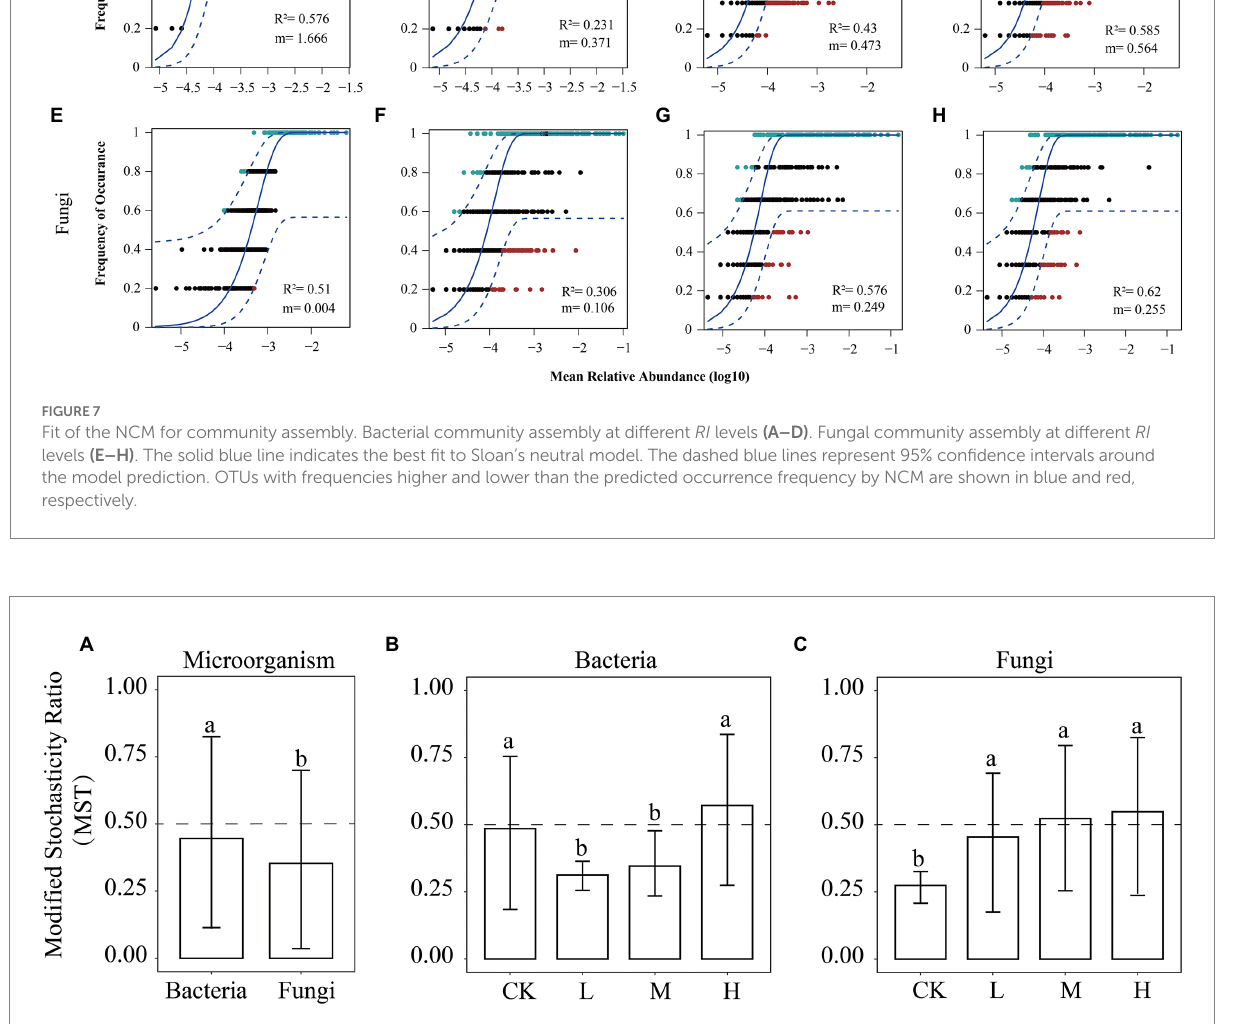
FIGURE 8 The MST ratio of microorganisms (A) , bacteria (B) , and fungi (C) . The dotted line at 0.5 is the boundary point between more stochastic (MST > 0.5) and deterministic (MST < 0.5) assembly processes. Different lowercase letters indicate significant differences among the different RI levels ( p <